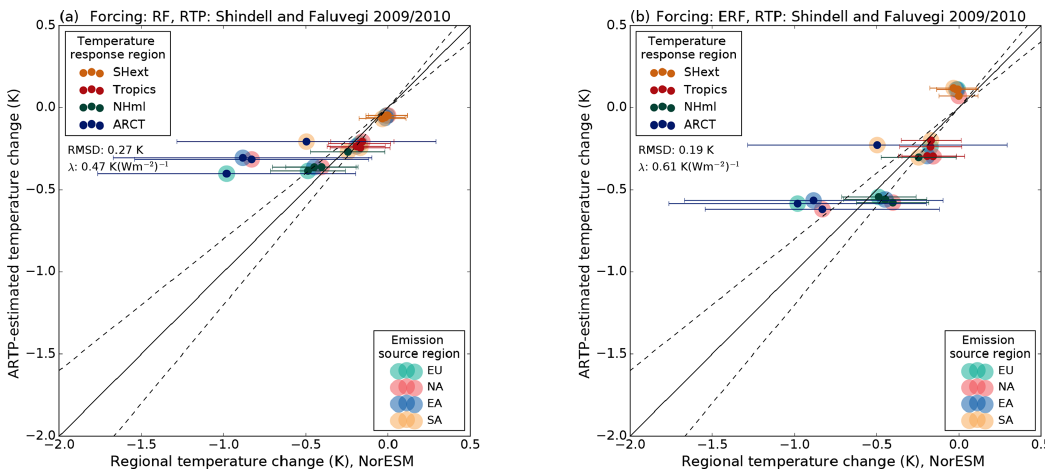
Figure 11. Regional temperature change from the coupled simulations (horizontal axis) compared with the estimated temperature response when using (a) RF and (b) ERF in combination with the RTP coefficients of Shindell and Faluvegi (2009), Eq. (1) with the climate sensitivity derived from the current experiments (vertical axis). The horizontal bars indicate 1 standard deviation for the temperature response in the coupled simulations. The dashed lines show a ± 20% agreement threshold.